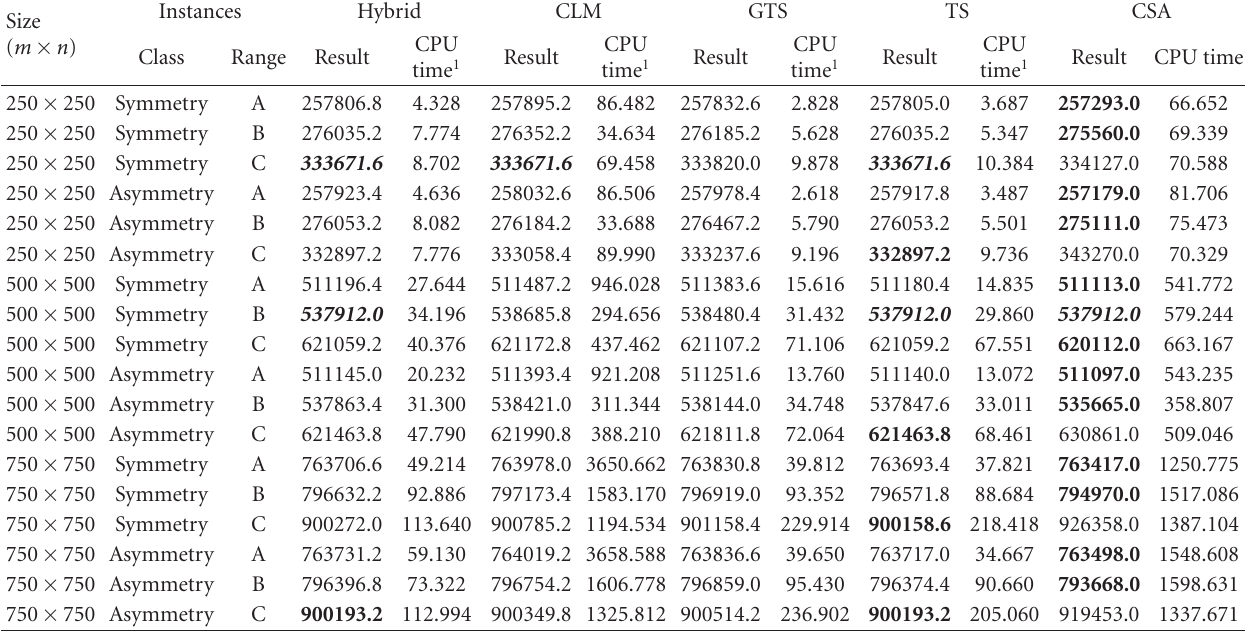
Table 2: Comparison for the Ghosh